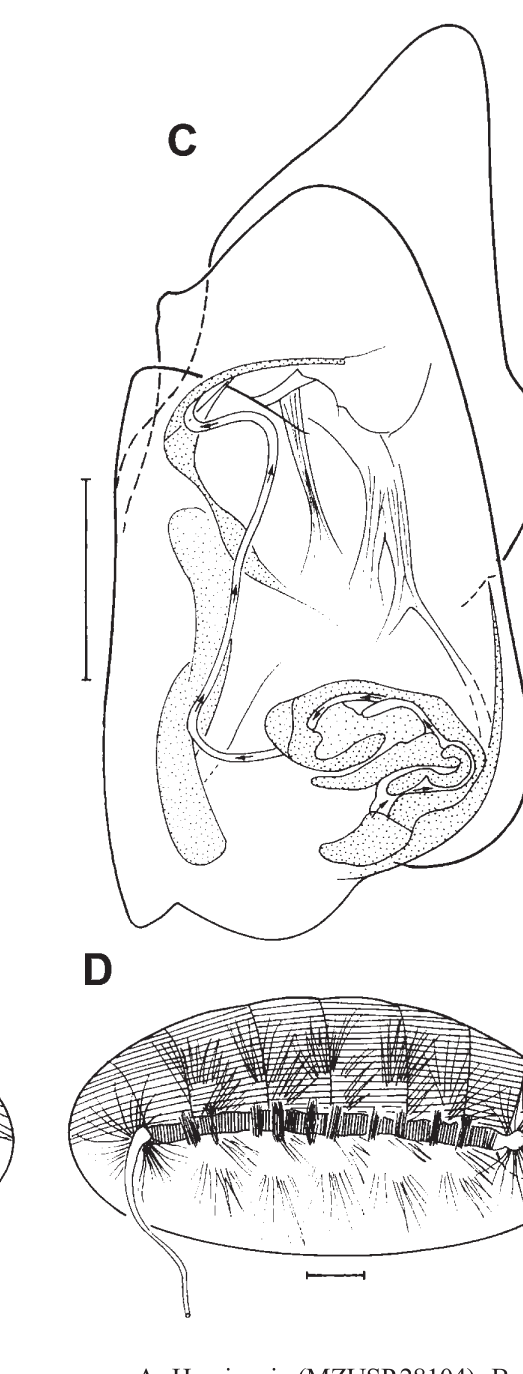
Fig. 7. — A, B . Candobrasilopsis rochai gen. nov. sp. nov. A. Hemipenis (MZUSP.28104). B. Zenker organ (MZUSP.28115). — C, D . C. brasiliensis (Sars, 1901) comb. nov. C. Hemipenis (OC.3296). D. Zenker organ (OC.3296). Scale bars: A, C, D = 50 µm, B = 100